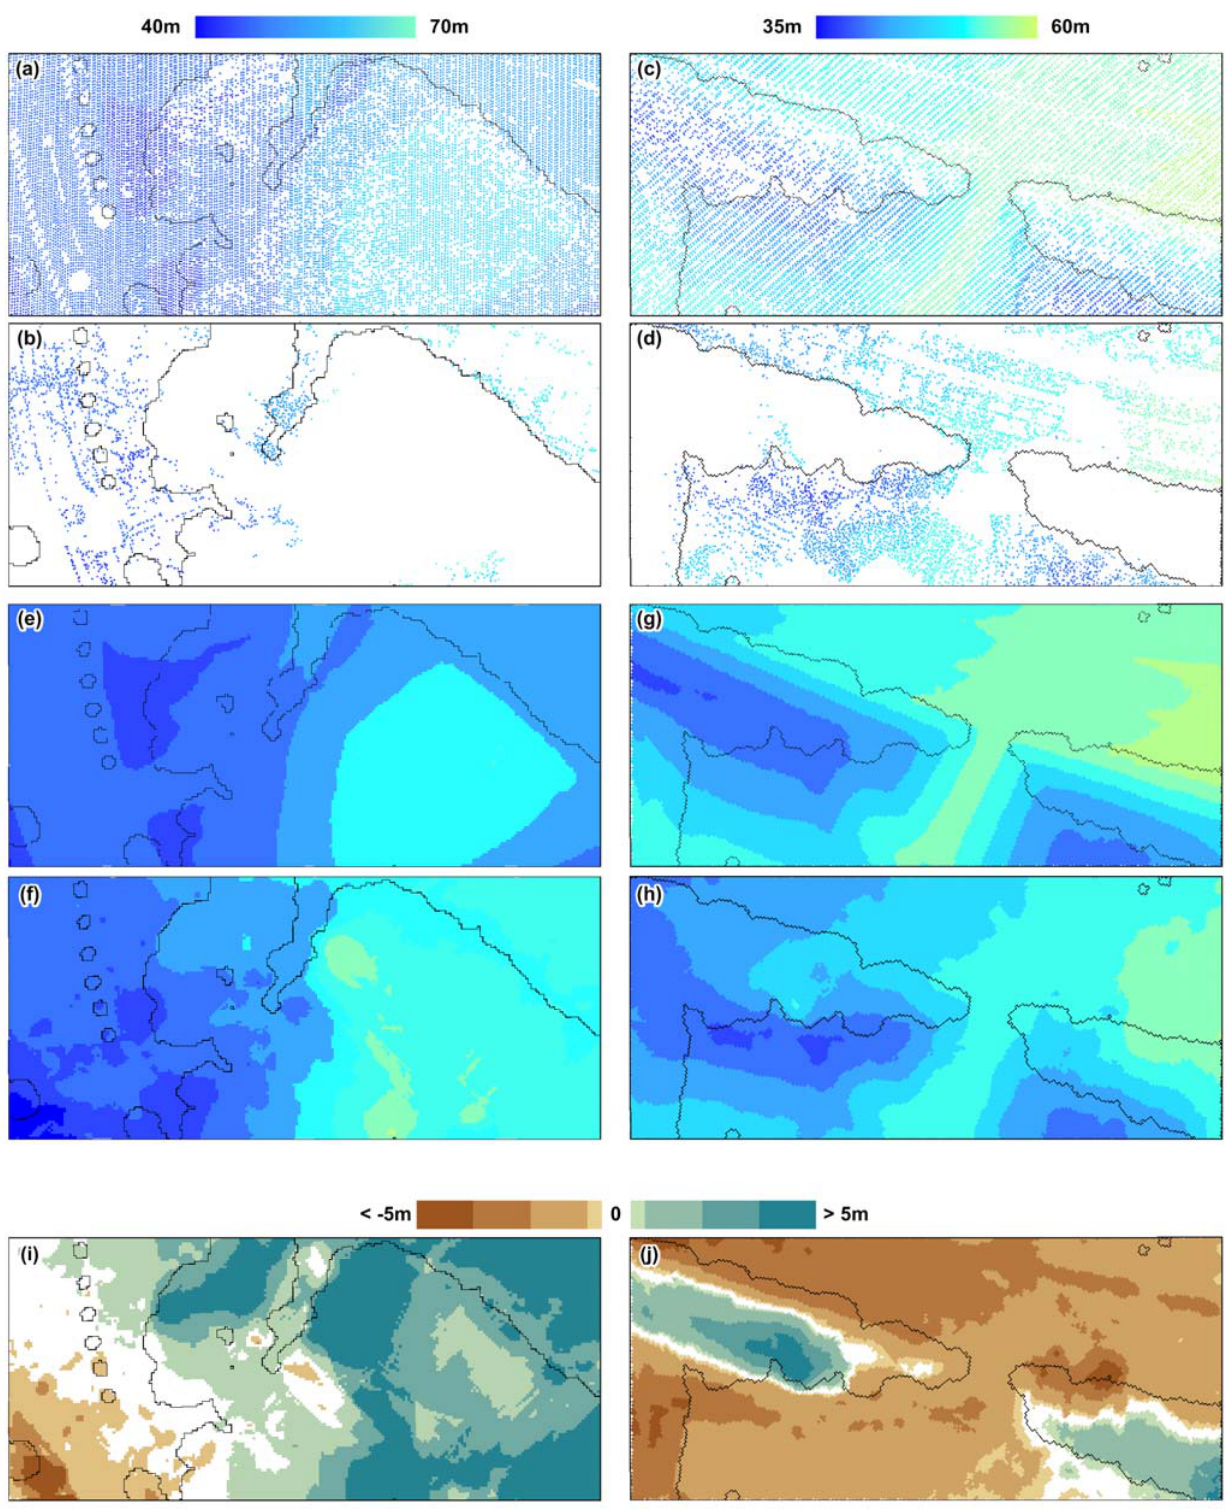
Figure 5. LiDAR and Ecosynth ground points ( a – d ), DTMs ( e – h ) and DTM differences ( i and j ). Ground points for Knoll site from LiDAR ( a ) and Ecosynth ( b ) and Herbert Run LiDAR ( c ) and Ecosynth ( d ). DTMs from Knoll LiDAR ( e ) and Ecosynth ( f ) and from Herbert Run LiDAR ( g ) and Ecosynth ( h ). DTM differences, Ecosynth—LiDAR, for Knoll ( i ) and Herbert Run ( j ). Site orientation and height colors in ( a ) to ( h ) are same as Figure 3. Black lines delimit tree canopy as determined from LiDAR